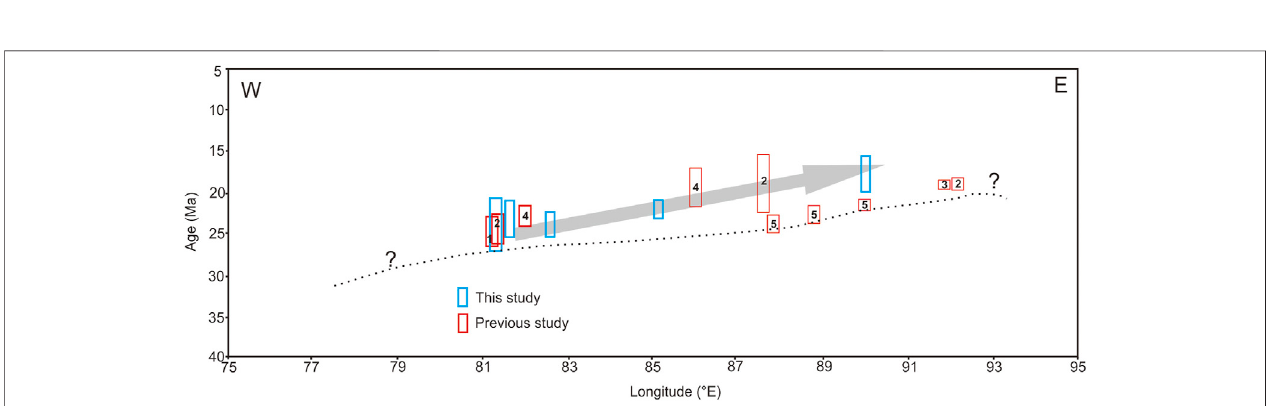
FIGURE 6 | Spatiotemporal distribution of sedimentary age of Gangdese conglomerate. Previous age data sources: 1) DeCelles et al., 2011; 2) Li et al., 2017; 3) Kong et al., 2015; 4) Carrapa et al., 2014; 5) Leary et al., 2016.